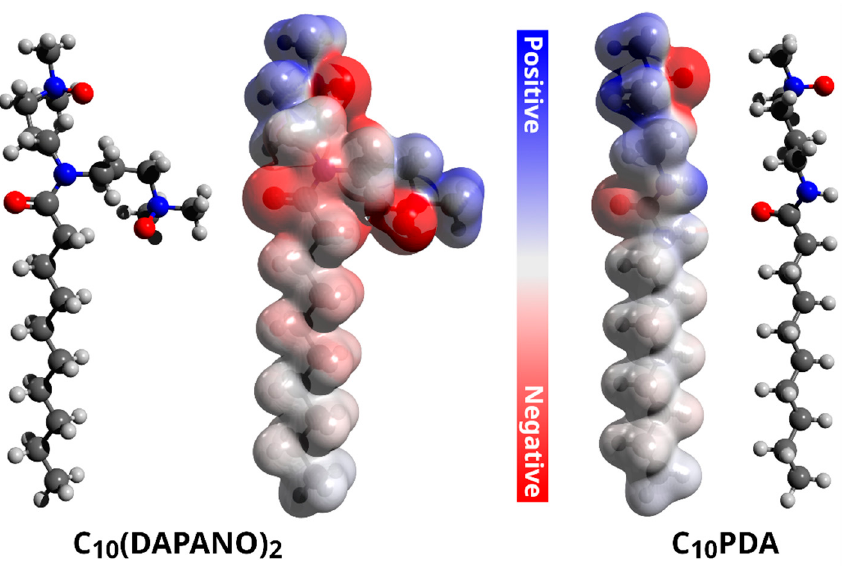
Figure 1. Electrostatic potential maps for the studied C 10 (DAPANO) 2 and C 10 PDA surfactants, which were computed at the DFT B3LYP/def2-TZVP level with implicit CPCM solvation. Red surfaces enclose a negative charge, while positive zones show as blue surfaces.